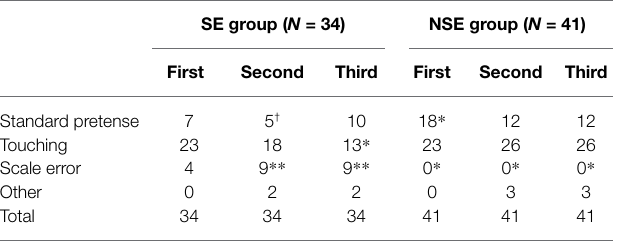
TABLE 4 | Frequency of each play (standard pretense, touching, scale error, and the other) at the first, second, and third times from the start of the task session for children in SE and NSE